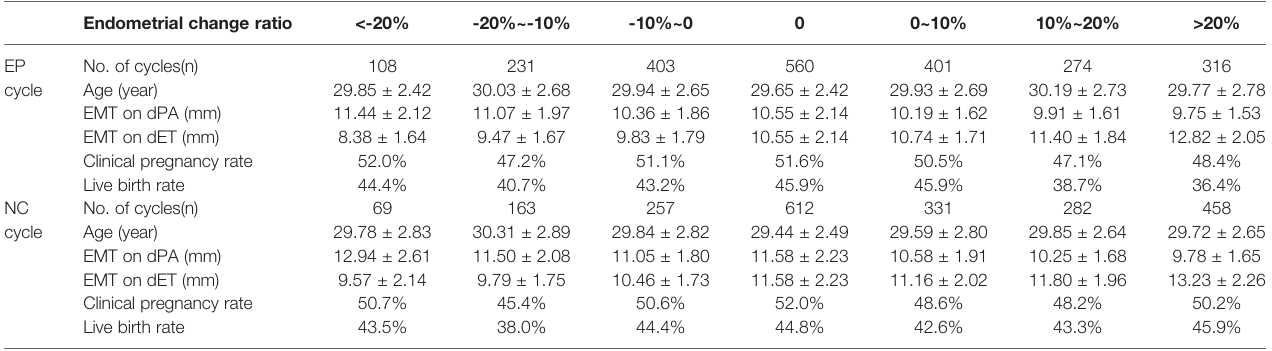
TABLE 3 | Endometrial thickness on the day before progesterone administration/embryo transfer and pregnancy outcomes according to the endometrial thickness change ratio.